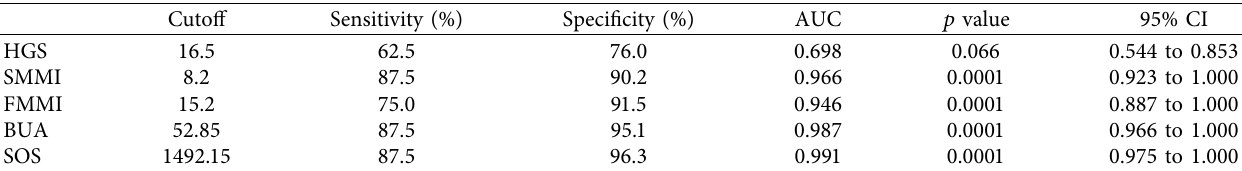
Table 4: Optimal cutoff, sensitivity, specificity, and area under the ROC curves in predicting osteosarcopenia in obese postmenopausal